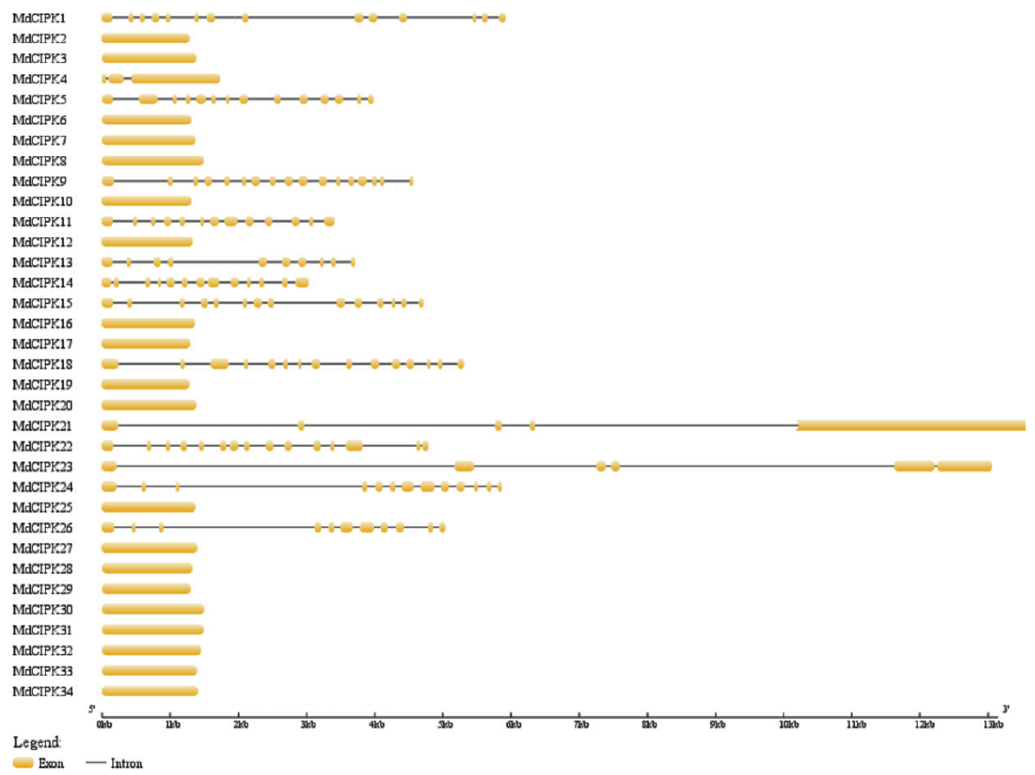
Figure 3. The exon-intron structure analyses of CIPK family in apple. Lengths of exons and introns of each MdCIPK gene were exhibited proportionally.